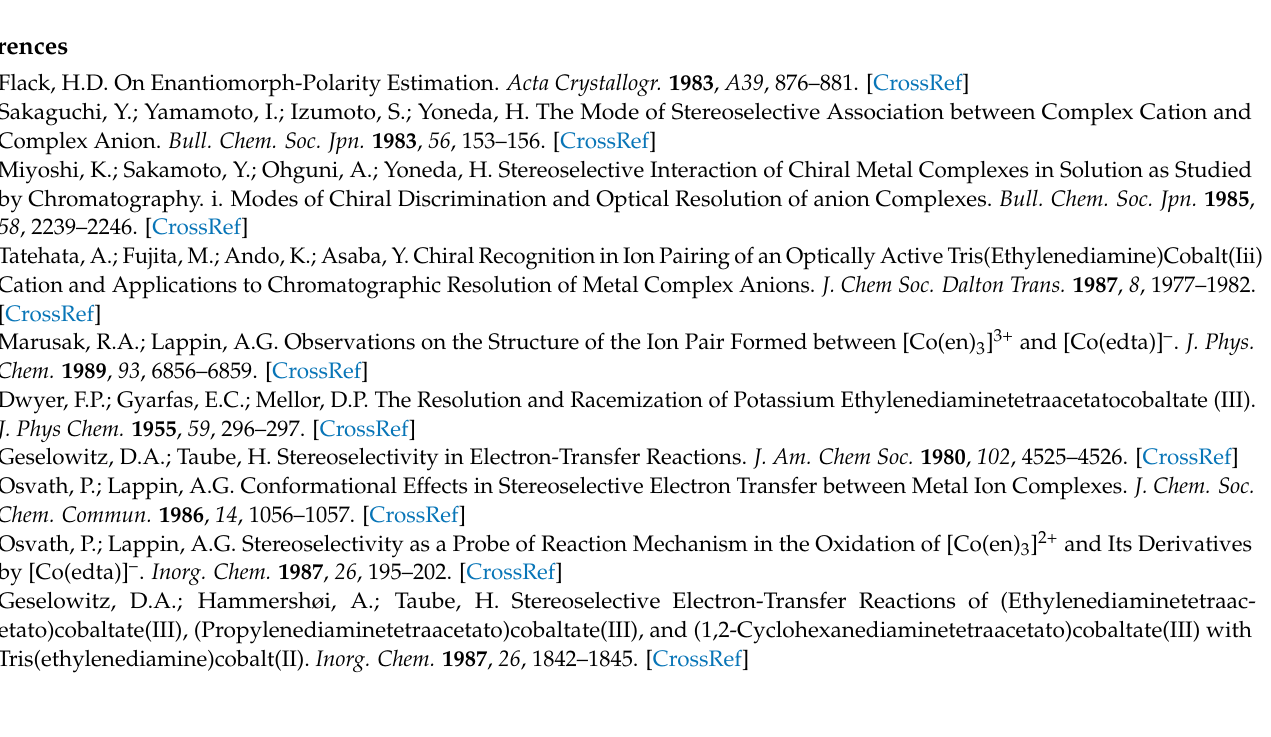
Figure S4: Labelling diagram for Λ -[Co(en) 3 ] ∆ -[Co(edta)] 2 Cl · 10H 2 O. X-Ray crystallographic files